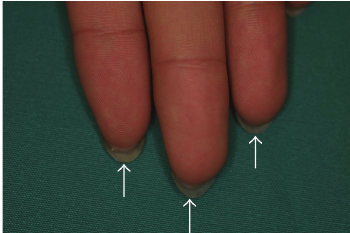
Figure 2: A ventral appearance of pterygium inversum unguis in a 16-year-old Japanese man. Marked subungual keratotic thickening is present on the distal nail unit of the left fingers (arrows).